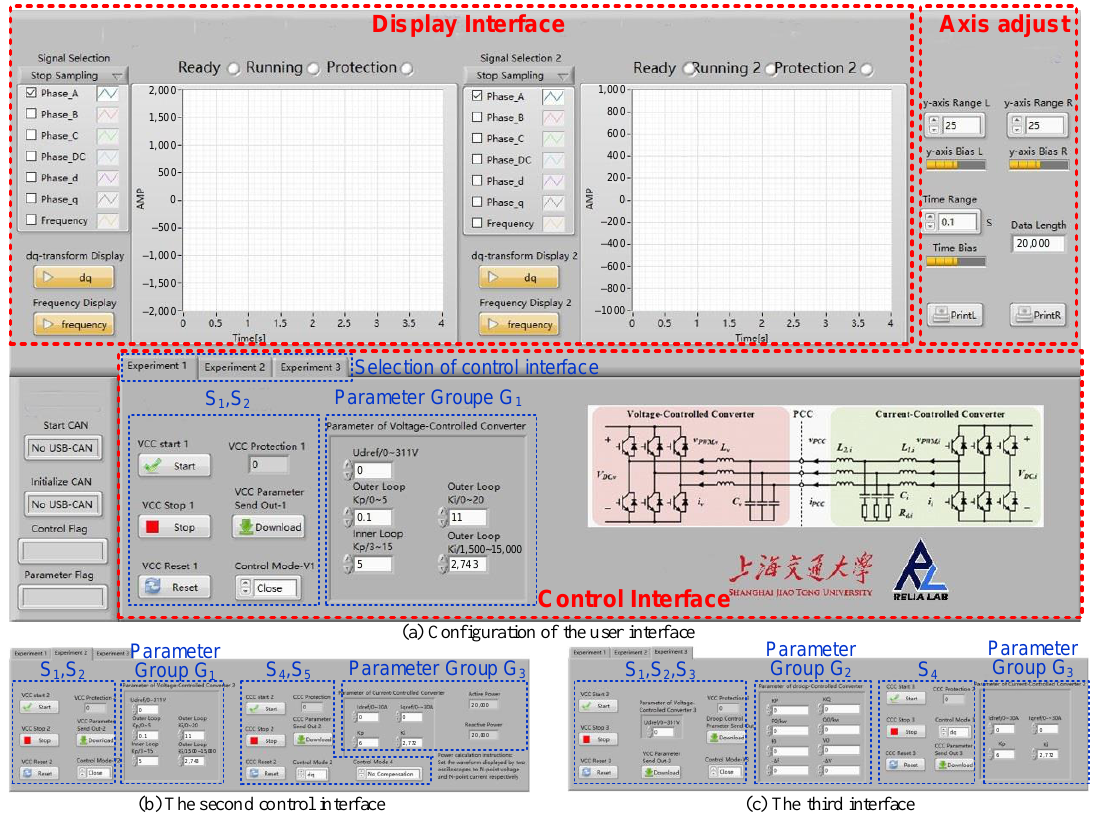
Figure 4. Configuration of the user interface in the host computer. VCC: voltage-controlled converter, CCC: current-controlled converter.